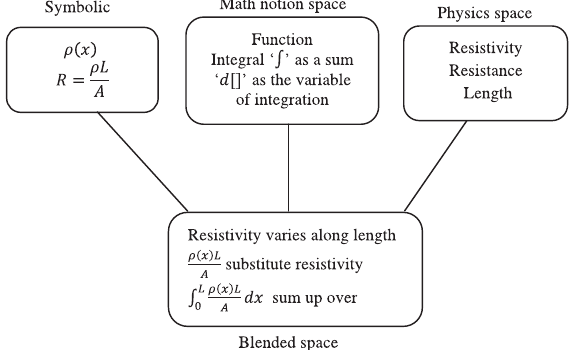
FIG. 1. Example of a blending diagram from the analysis by Hu and Rebello